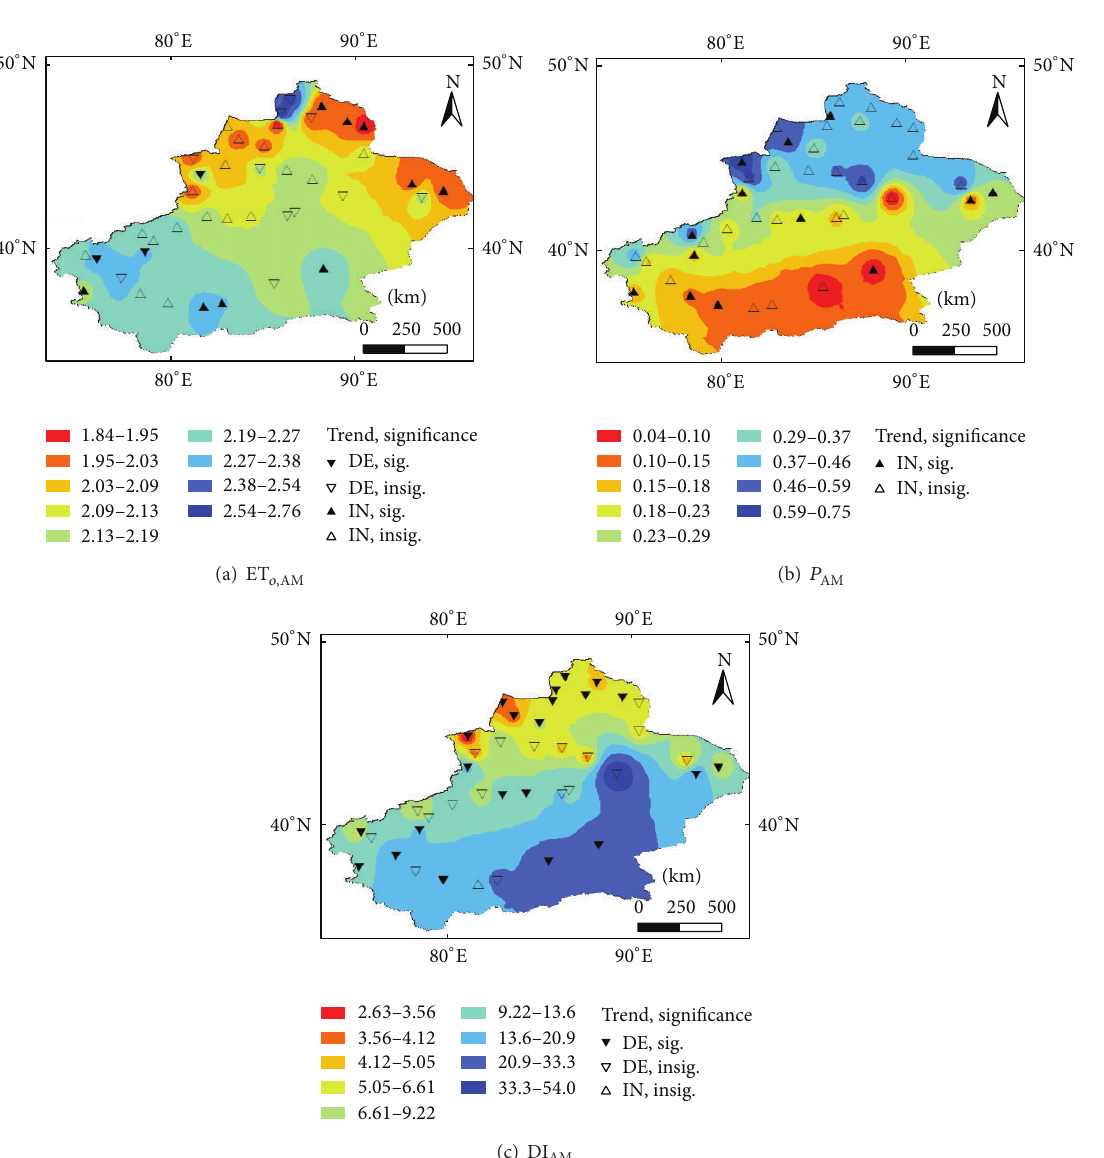
, 𝑃 , and DI over 1961–2010 in Xinjiang. DE: decrease, IN: increase, sig.: significant AM AM AM